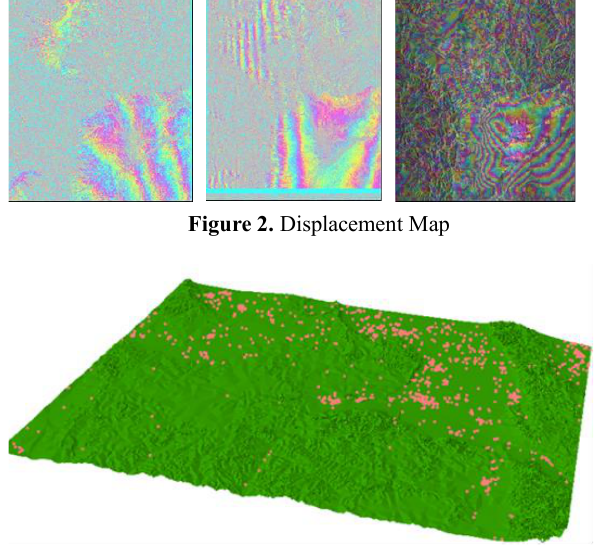
Figure 3. PS points 3D